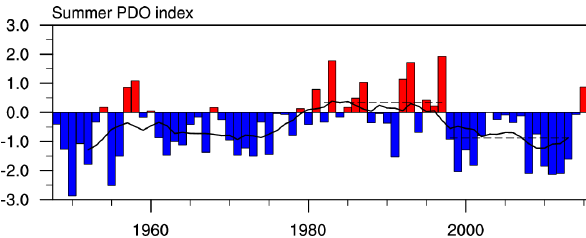
Figure 11. The PDO index in summer (JJA) from the NOAA Na- tional Centers for Environmental Information (NCEI). The solid line indicates the 9-year running average, and the dashed line in- dicates the average over 1982–1997 and